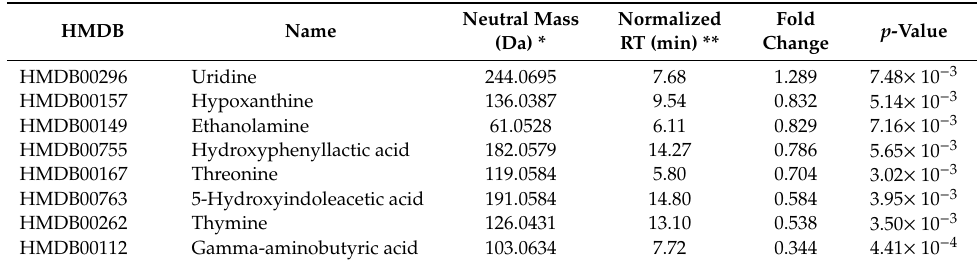
Table 3. Positively identified significantly di ff erentially expressed metabolites in the rat heart tissue after prolonged Dex